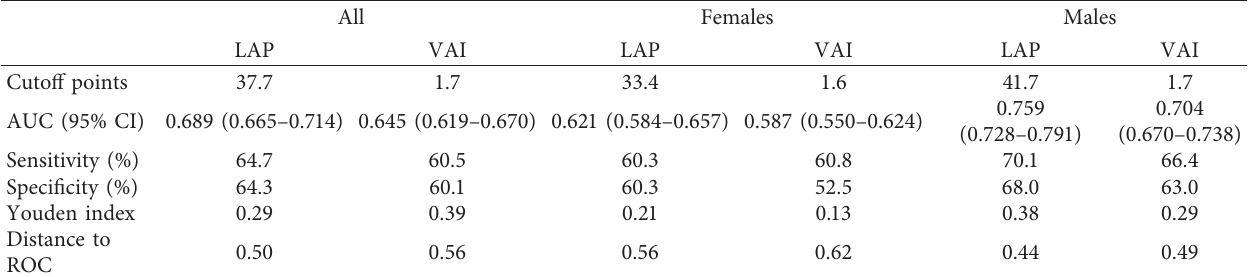
Table 2: Diagnostic parameters of LAP and VAI for insulin resistance prediction (Maracaibo, Venezuela).